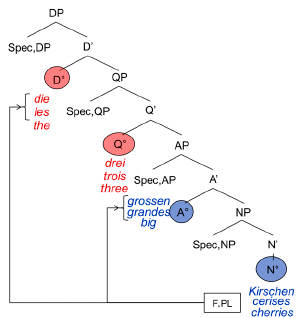
Figure 2. Simplified structure of the DP.